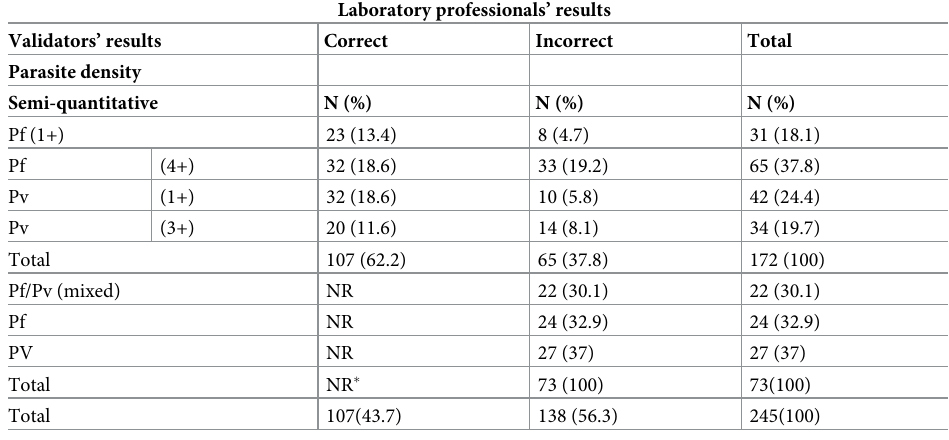
Table 2. Performance of laboratory professionals on quantification of parasite density at health facilities in Bahir Dar city administration from January to March 2017.